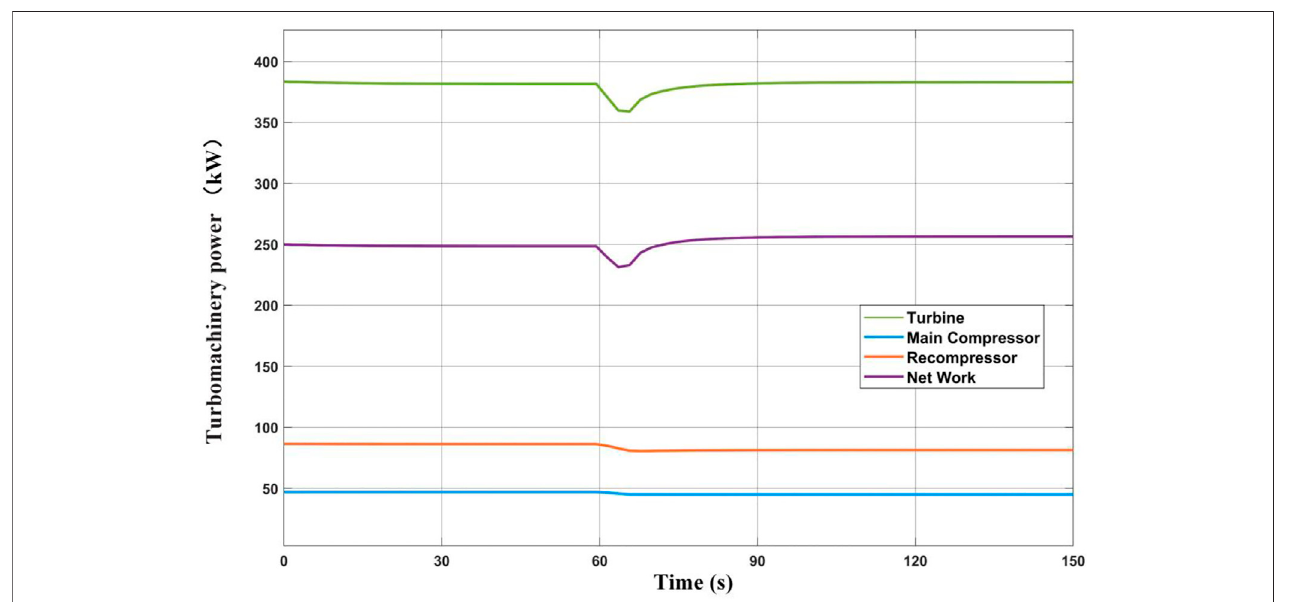
FIGURE 11 | Dynamic response of turbine machinery power while reducing the cycle mass fl ow rate.